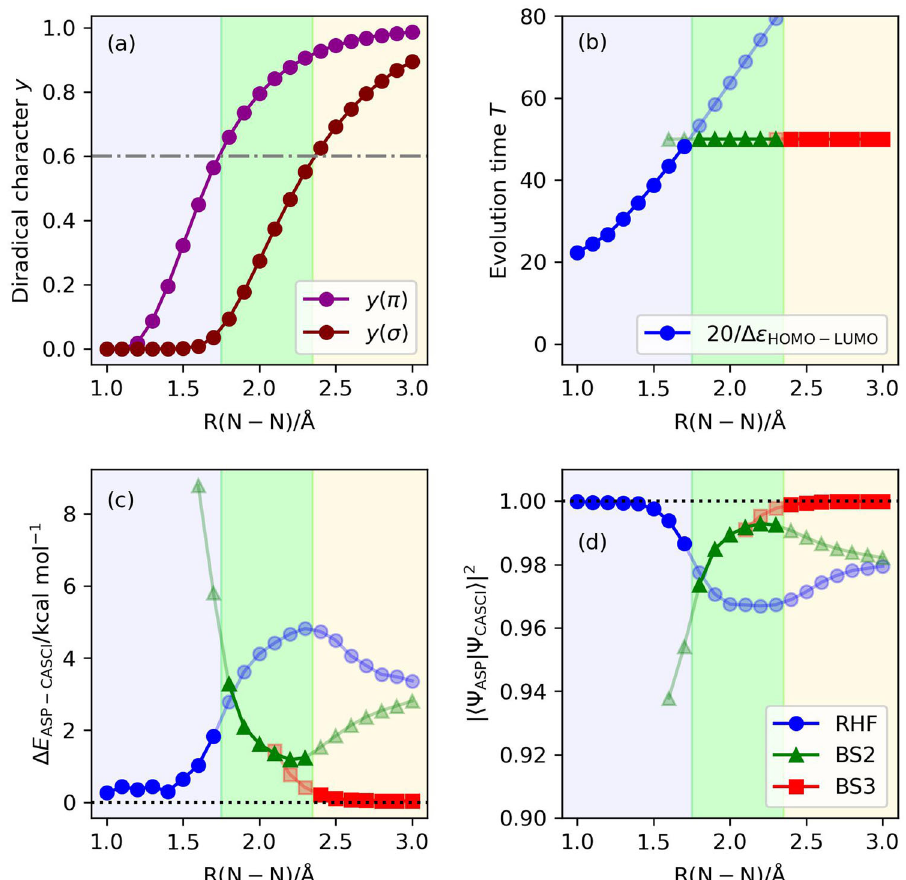
Fig. 8 Results of the numerical simulation of ASP of the potential energy curve for N 2 molecule, using the diradical characters as the indicator for selecting the initial wave function. Background colors specify the regions of the initial wave function recommended from the criterion based on the diradical character y > 0.6. Sinusoidal and square functions were adopted as the scheduling functions with the | Ψ HF 〉 and | Ψ BS 〉 , respectively, as the starting wave function. a Diradical characters calculated using Eq. 6. b Evolution time lengths. c The energy differences from the CASCI values. (d) The square overlaps with the CASCI wave